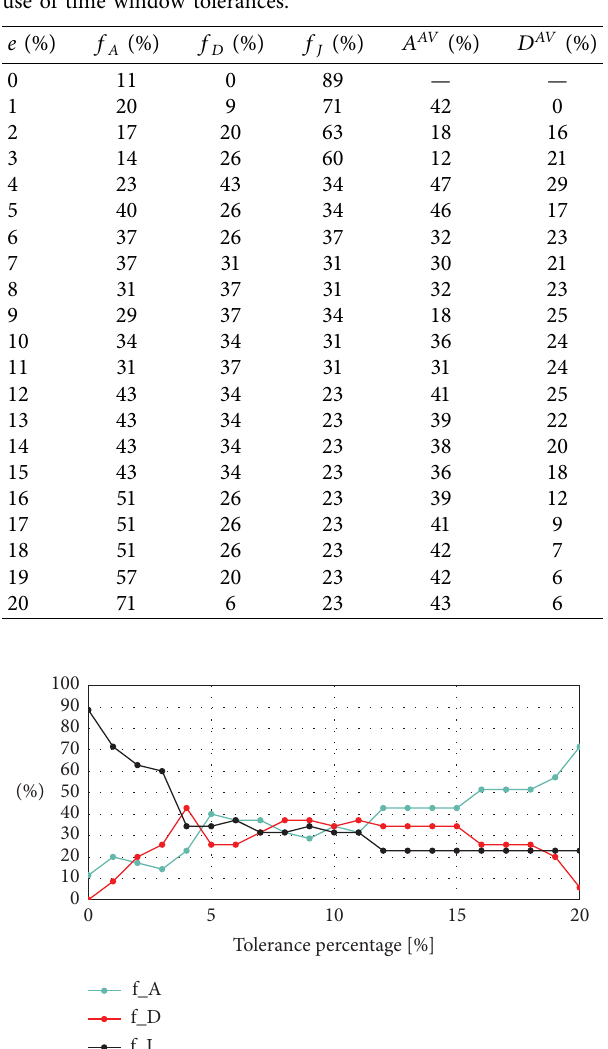
Figure 9: Evolution of the performance indicators of the activities advanced, delayed, or executed in their tentative